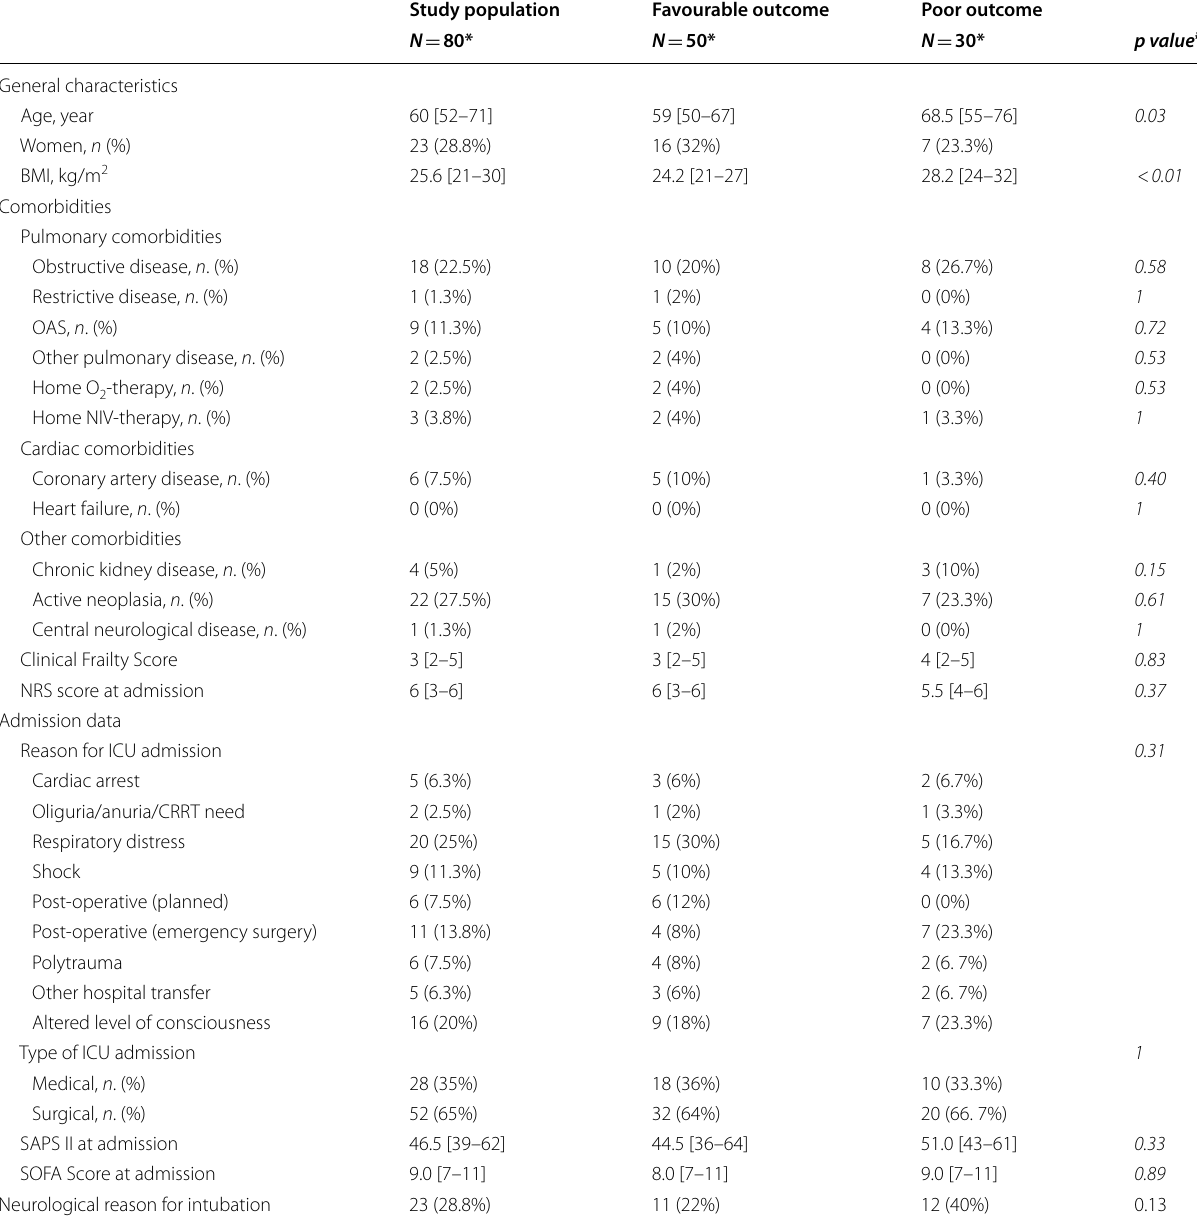
Table 1 Patients’ general characteristics, comorbidities and admission